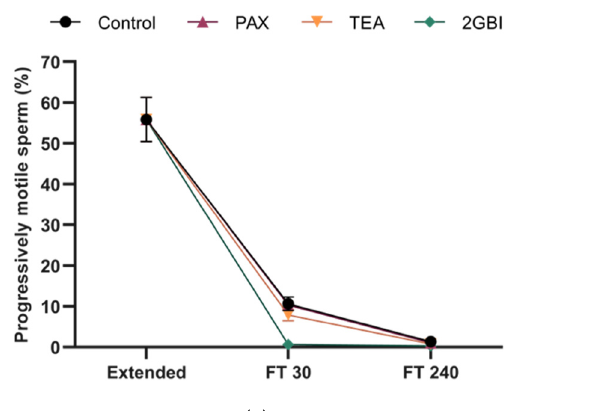
Figure 2. Percentages of total ( a,b ) and progressive ( c,d ) motile spermatozoa in extended and frozen–thawed (FT) samples at 30 min and 240 min post-thaw. In Experiment 1 ( n = 8), TEA, PAX, and 2-GBI blockers were added to LEY medium at 15 °C ( a,c ), whereas in Experiment 2 ( n = 9), they were added to LEYGO medium at 5 °C ( b,d ). Different superscripts indicate significant differences ( P < 0.05) between samples within the same time point. Results are given as mean ± SEM.